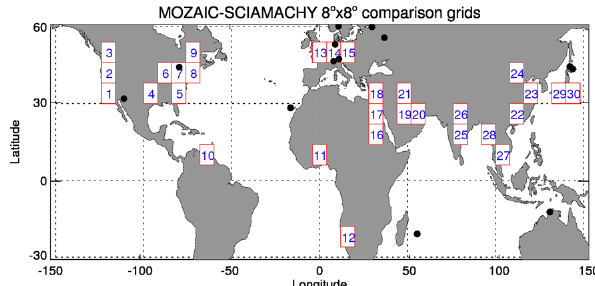
Figure 2. Grid areas of 8º×8º with at least 25 MOZAIC comparison values for the period 604 Fig. 2. Grid areas of 8 ◦ × 8 ◦ with at least 25 MOZAIC comparison values for the period 2003–2008 (see Sect. 2 for explanation of how 2003-2008 (see section 2 for explanation of how the comparison is devised). Grids are 605 the comparison is devised). Grids are numbered from south to north numbered from south to north and west to east for use in other figures. The black dots 606 and west to east for use in other figures. The black dots denote GBS denote FTIR locations used for validation of SCIAMACHY CO in de Laat et al. [2010b]. 607 locations used for validation of SCIAMACHY CO in de Laat et al. (2010b).